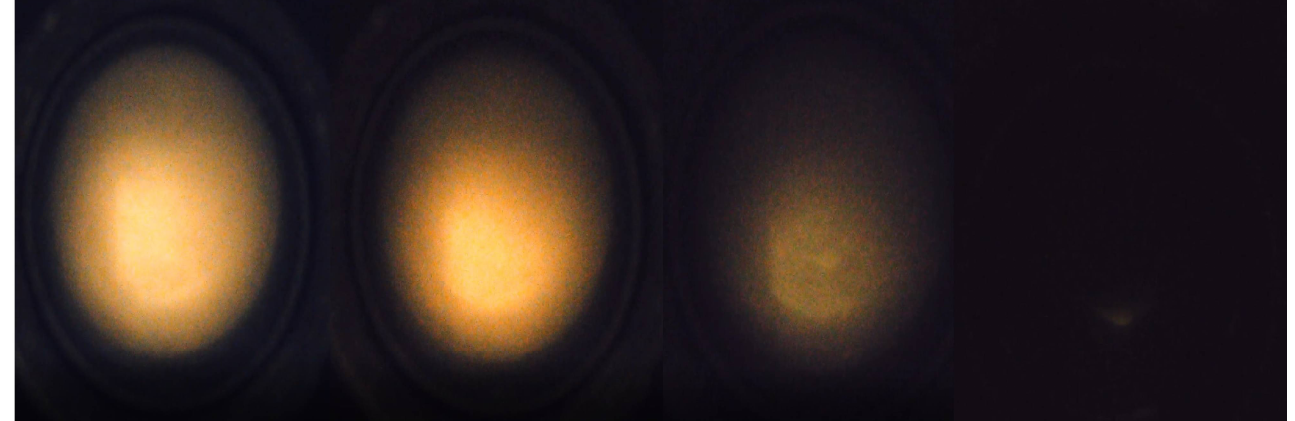
Figure 9. Images of the sapphire visor on VN2 during the experiment, scale 1:1.